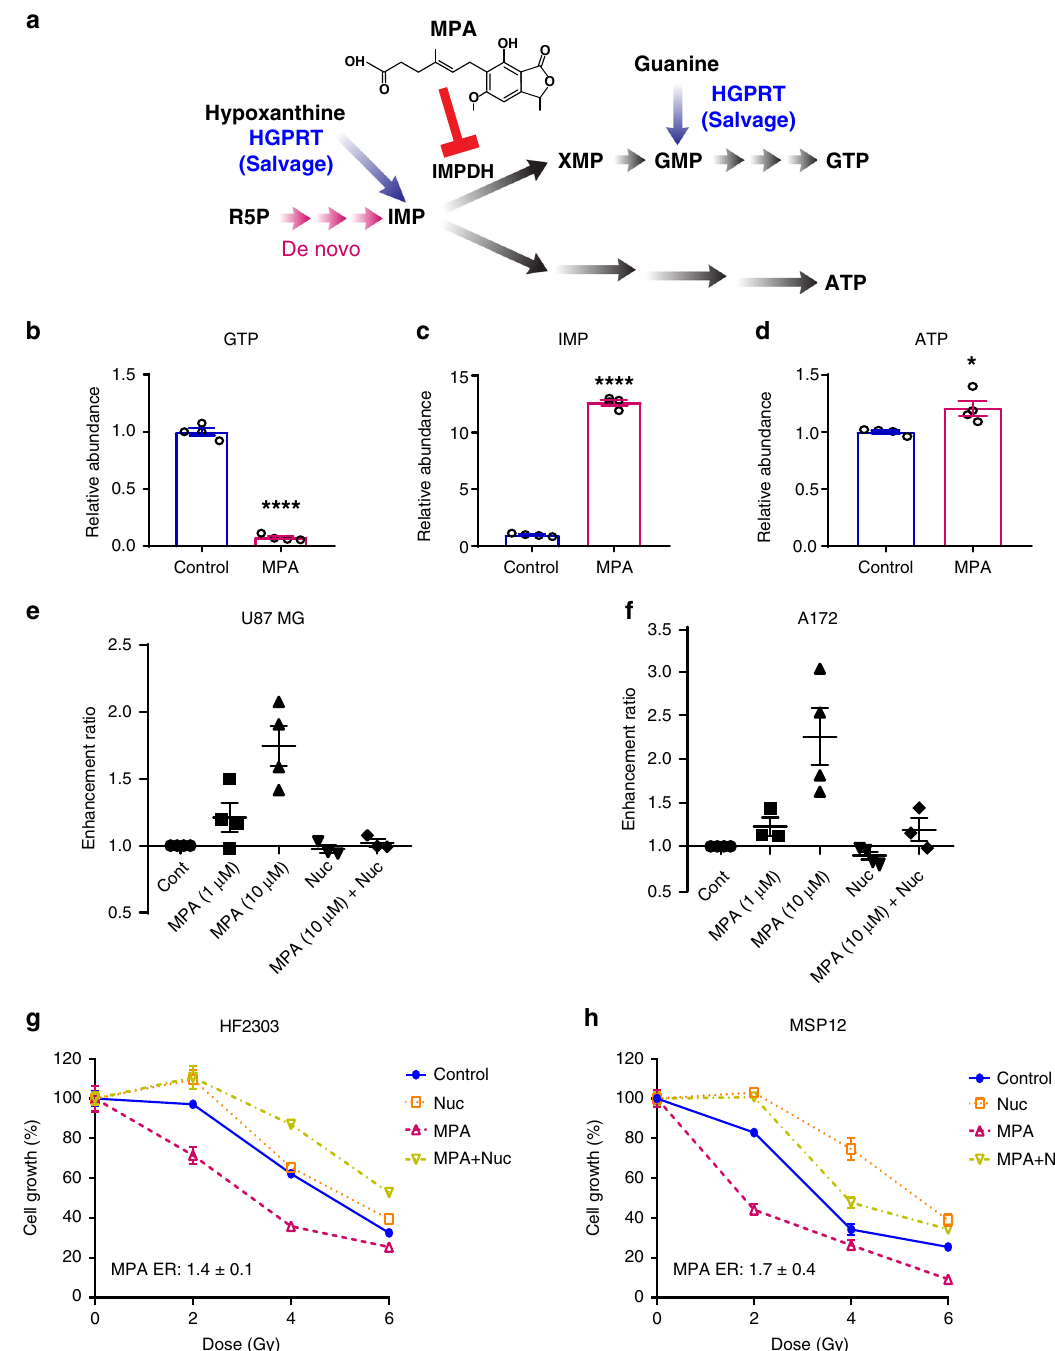
Fig. 3 Inhibiting GTP synthesis radiosensitizes RT-resistant GBM cell lines and patient-derived neurospheres. a Purine synthesis schematic. R5P: Ribose 5-phosphate; IMP: inosine monophosphate; GTP: Guanosine-5 ’ -triphosphate; ATP: Adenosine triphosphate; IMPDH: Inosine-5 ’ -monophosphate dehydrogenase; HGPRT: hypoxanthine-guanine phosphoribosyltransferase; MPA: mycophenolic acid. b – d U87 MG cells were treated with MPA (10 μ M) for 24 h, and then harvested and analyzed by targeted LC-MS/MS. Data are presented as mean ± SEM from four biologic replicates. p values are <0.0001, <0.0001, and 0.0237 for Fig. b – d , respectively. * p < 0.05, and **** p < 0.0001 compared with control. The p values indicated were obtained by two-tailed unpaired student's t test. e , f After treatment with indicated conditions, cells were replated for colonogenic assay and colonies were stained and counted